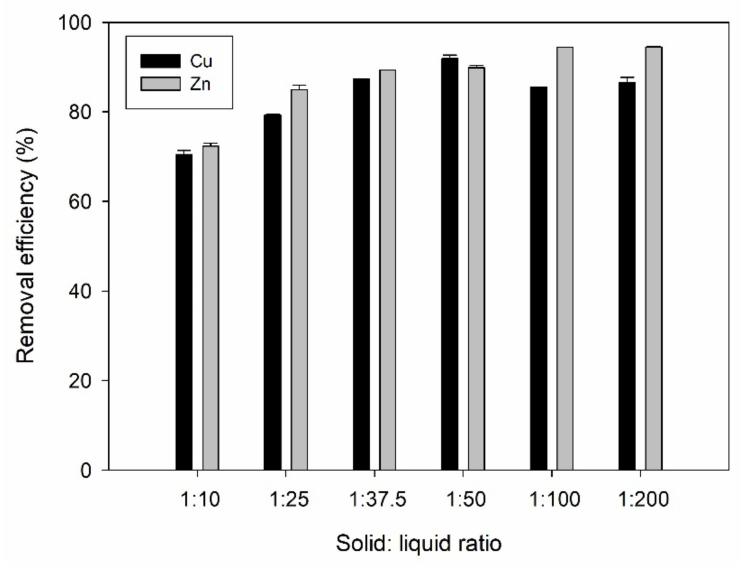
Figure 1. The effect of solid to liquid ratio on removal efficiency of Cu and Zn from swine feces.